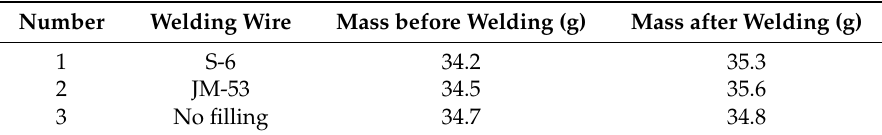
Table 12. Mass variation of test specimens before and after